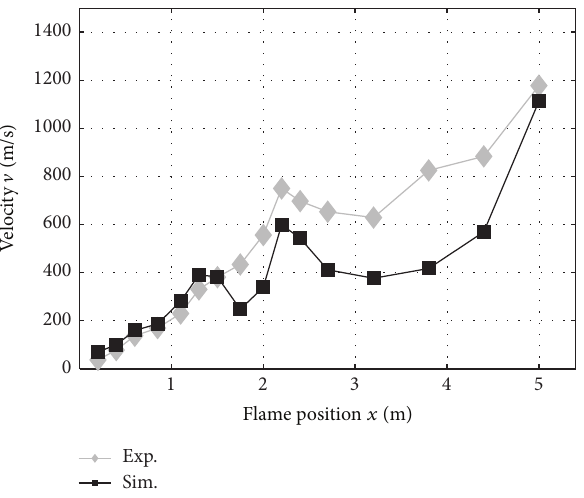
Figure 7: Flame propagation in a mixture with 15% H 2 (max. concentration